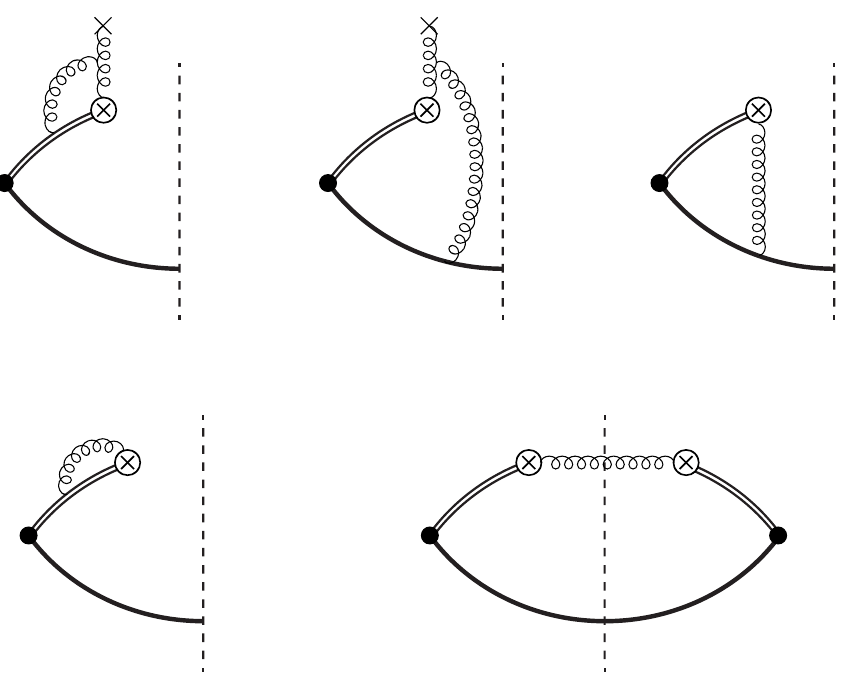
Figure 2 . Representative one-loop Feynman diagrams for B 00 . The ⊗ symbol is the chromomagnetic field, and the symbol × represent contributions from nonperturbative/external gluon